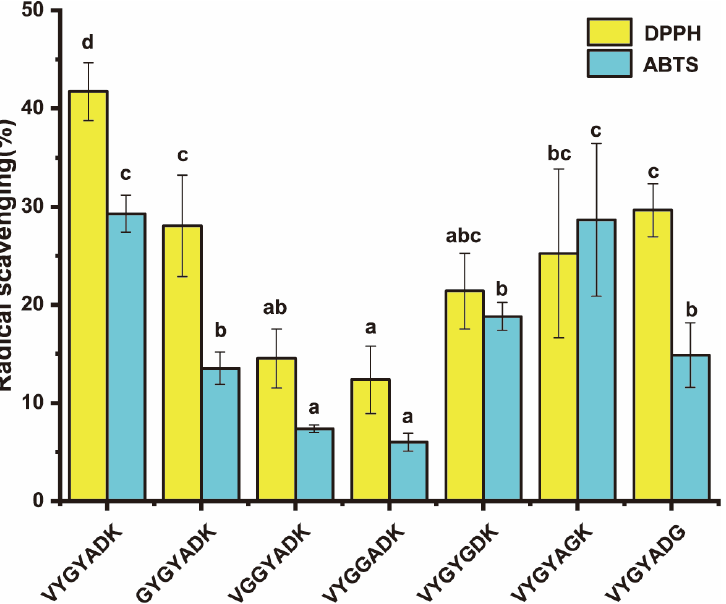
Figure 7. Identification of key amino acids of VYGYADK in scavenging free radical. DPPH free radical scavenging capacity and ABTS free radical scavenging capacity of VYGYADK and its mutants. Different lowercases above the error bar indicated significant differences among various synthetic antioxidant peptides ( p < 0.05). The data shown are mean ± SD ( n = 3).